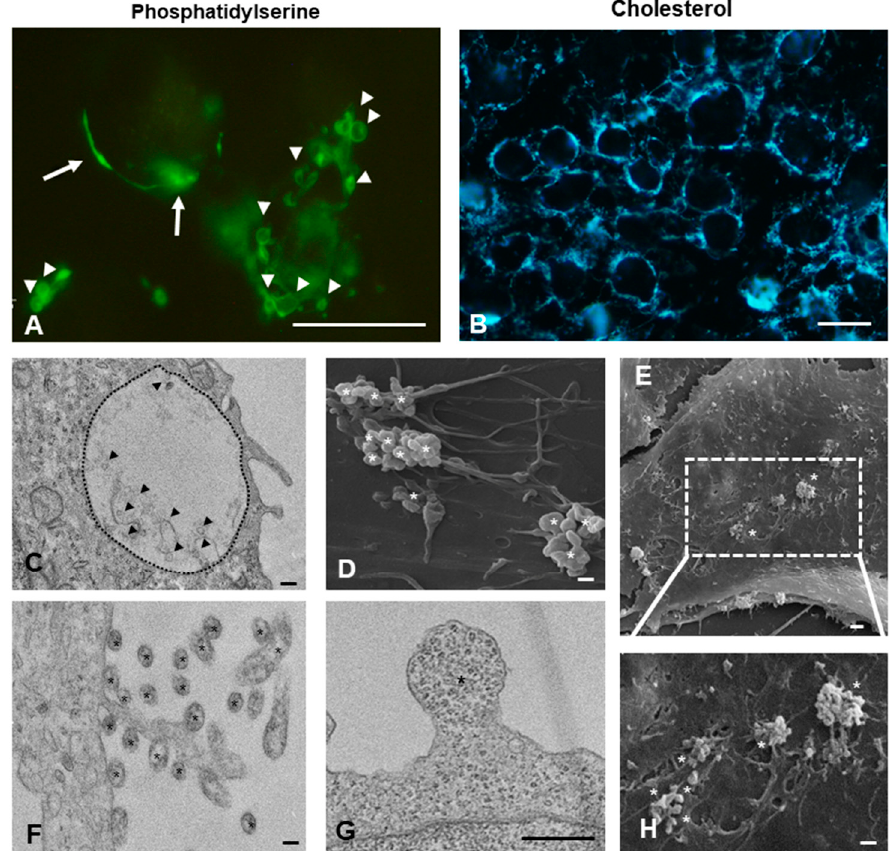
Figure 2. Fluorescent and electron microscopic analysis of U87-MG cells. ( A,B ) Fluorescent labeling of phosphatidylserine residues (FITC-conjugated annexin-V) and cholesterol (filipin) on plasma membrane of U-87 MG cells. Arrow: clustering of PS residues. Arrow head: vesicles. Bar = 10 µ m. Transmission Electron Microscopy (TEM) ( C,F,G ) and Scanning Electron Microscopy (SEM) of U-87 MG ( D,E,H ) cells. Micrographs show large EVs (asterisks) shed from plasma membrane and small EVs (arrow heads) inside multivesicular bodies (dashed black line). Bar = 200